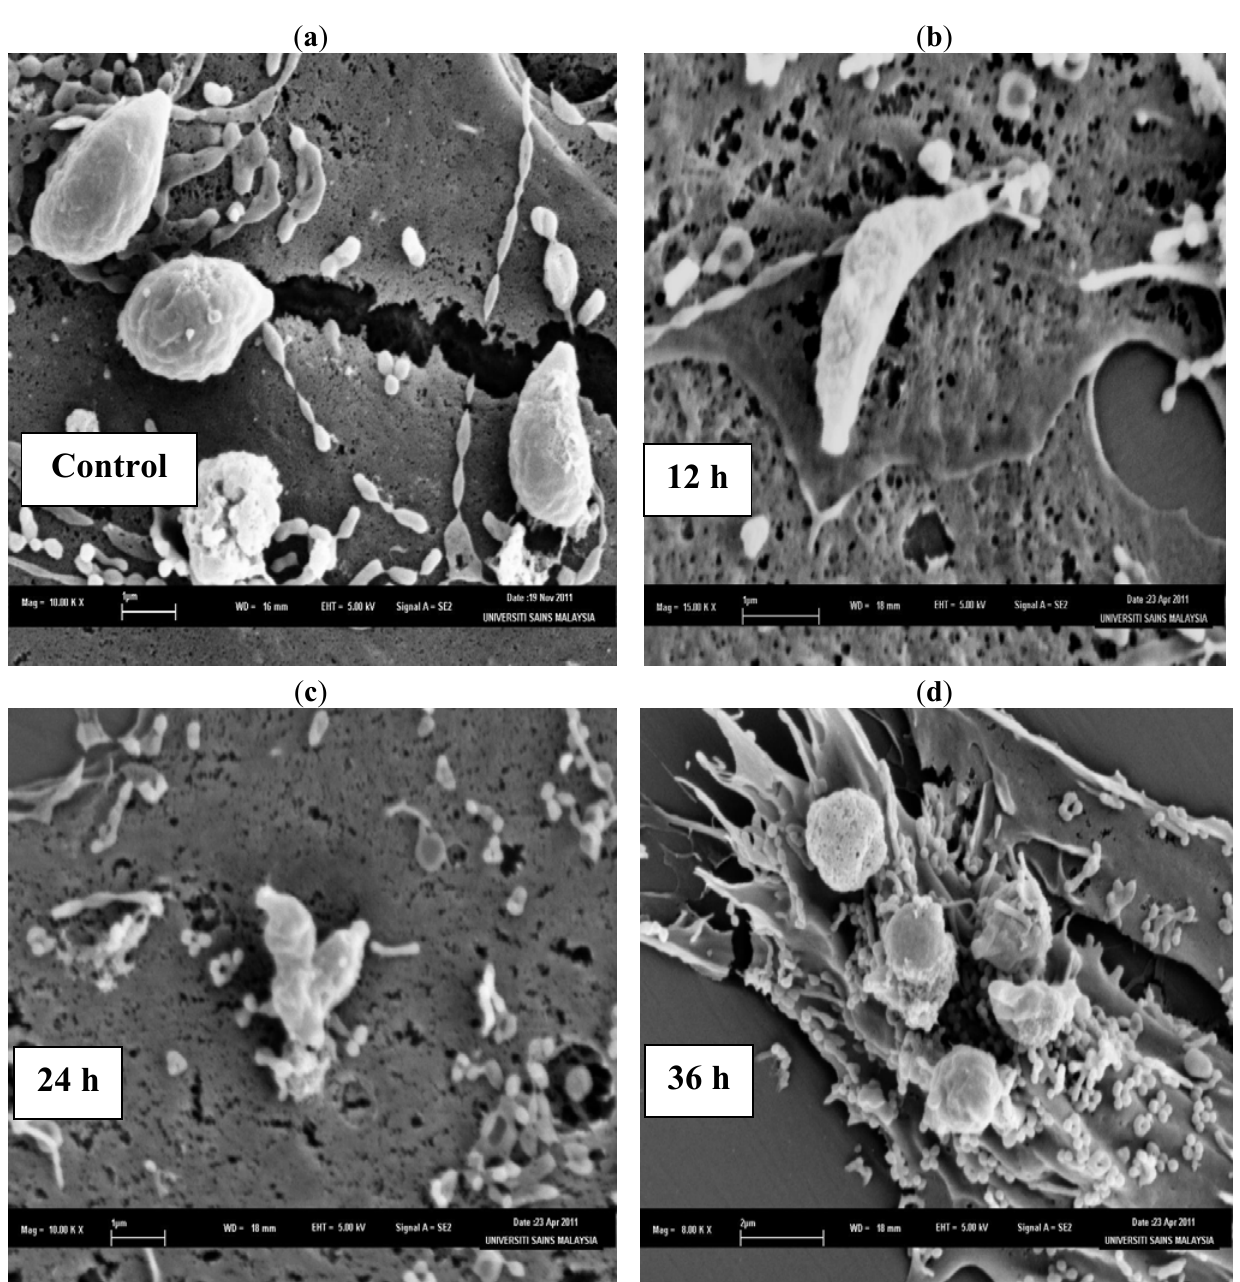
Figure 2. SEM micrograph of the untreated and TAF355 treated cells of T. gondii after different time intervals. ( a ) Untreated cells, ( b ) 12 h of exposure, ( c ) 24 h treated cells, ( d ) 36 h of